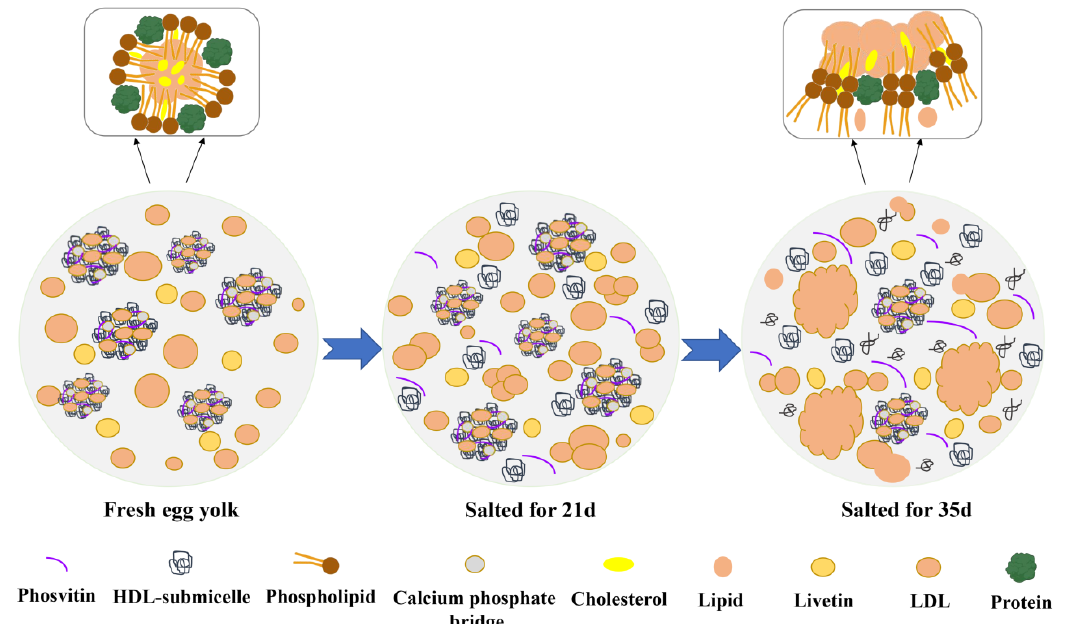
Figure 3. Diagram of gel formation mechanism of salted egg yolk.